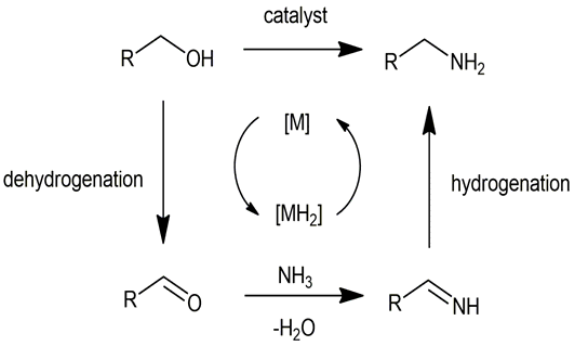
Table 1. Conversion of cyclohexanol into cyclohexylamine over Raney Ni in aqueous ammonia with different amount of NaOH a .